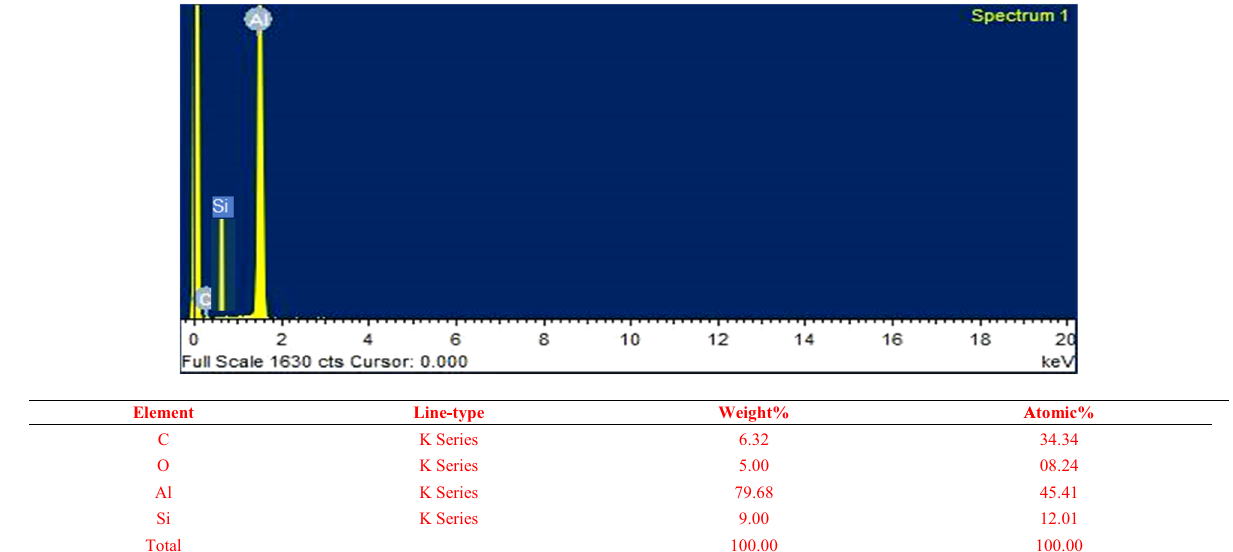
Figure 2: EDS analysis of SiC p /Gr p /Al - MMC hybrid composites.